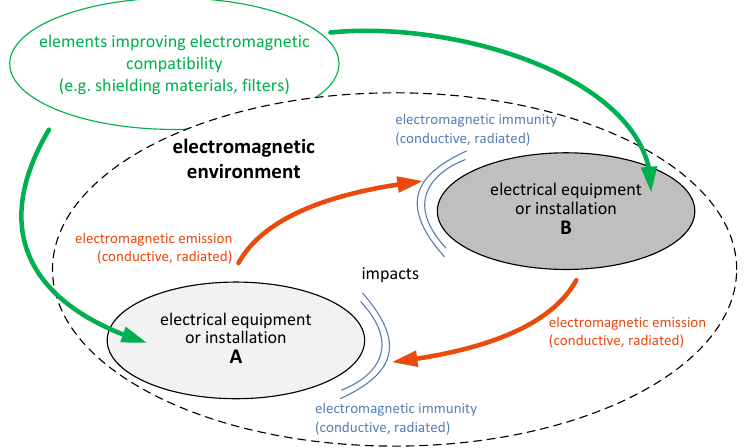
Figure 1. Electromagnetic compatibility — the idea of interaction.